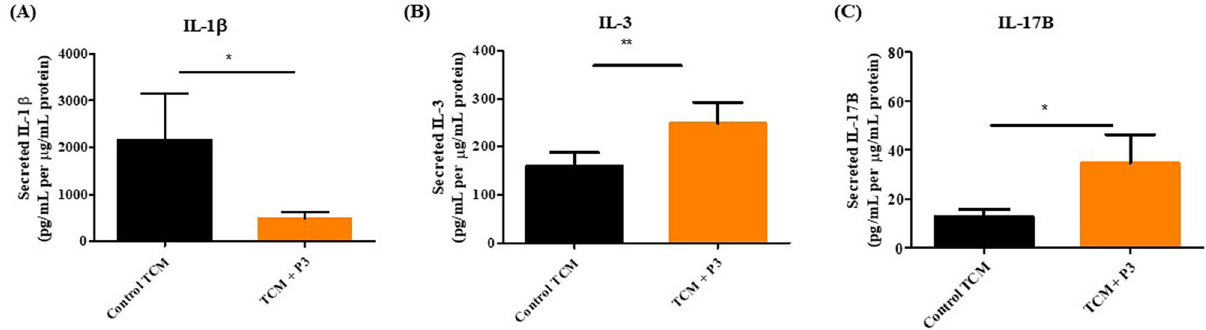
Figure 6. Pyrazinib (P3) significantly reduces secretion of IL-1β and increases secretion of IL-3 and IL-17B from OAC treatment biopsies. The effect of 24 h treatment of OAC treatment-naïve biopsies with 0.1% DMSO or 10 µM Pyrazinib (P3) on protein secretion was assessed by multiplex ELISA. ( A ) Pyrazinib (P3) significantly reduced the secretion of IL-1β from OAC treatment-naïve biopsies, (n = 22). ( B ) Pyrazinib (P3) significantly increases the secretion of IL-3 from OAC pre-treatment biopsies, (n = 15). ( C ) Pyrazinib (P3) significantly increases the secretion of IL-17B from OAC pre-treatment biopsies, (n = 15). Wilcoxon signed rank t-test,* p < 0.05, ** p < 0.01. All data normalised to protein content. Data expressed as +